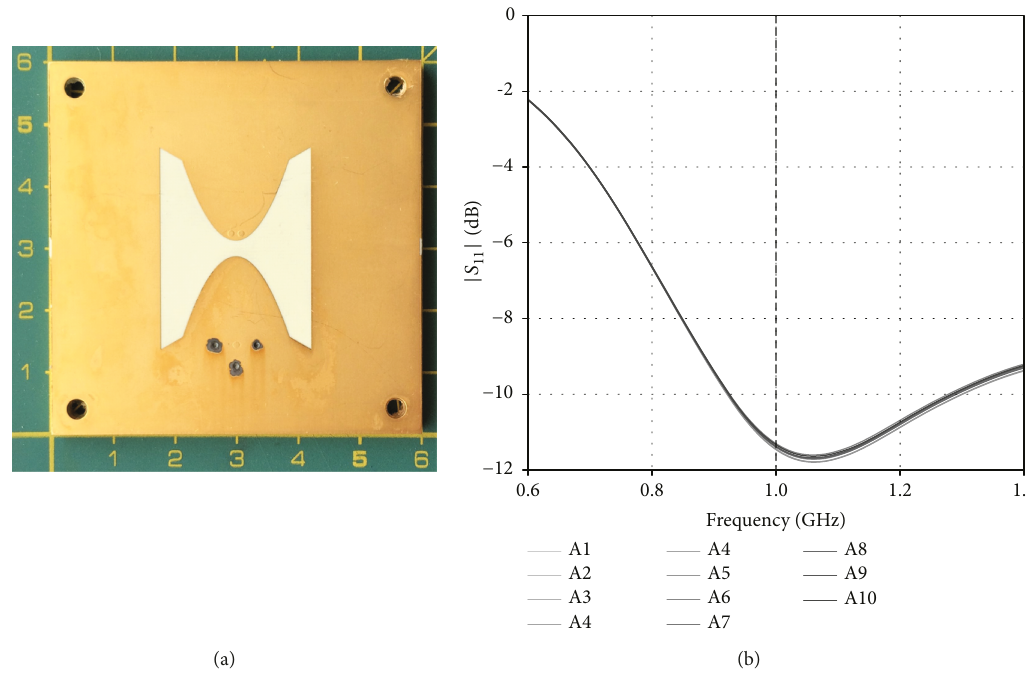
Figure 3: Photograph of the antenna element from the side facing to the phantom (a) (dimensions in cm) and measured magnitude of S for all antennas in frequency range 0.6 - 1.4GHz heading to the liquid homogeneous phantom of human head (b). Central operating frequency is marked by a dashed line.